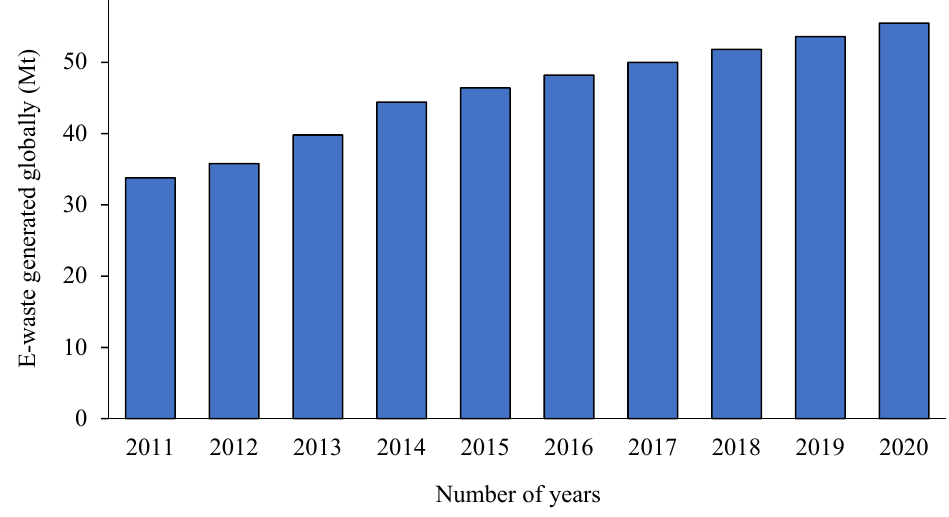
Figure 1. Electronic waste generated globally in the past decade [13].